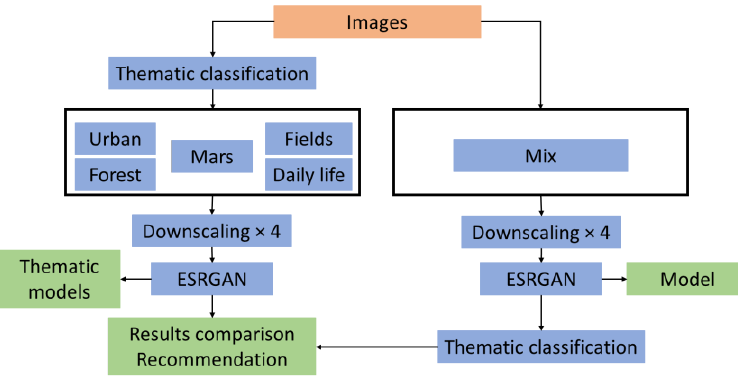
Figure 5. Methodological flowchart.